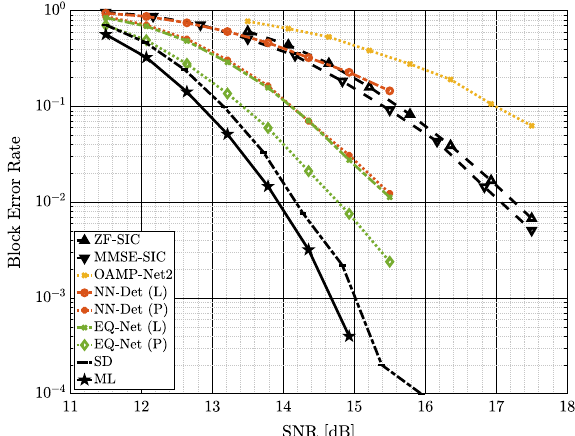
Fig. 8 Estimation (MIMO detection) performance of EQ-Net versus state-of-the-art approaches in 2 × 2 , 64-QAM Rayleigh fading, and LDPC-coded with size (324, 648). Table 2 compares the inference latency of the